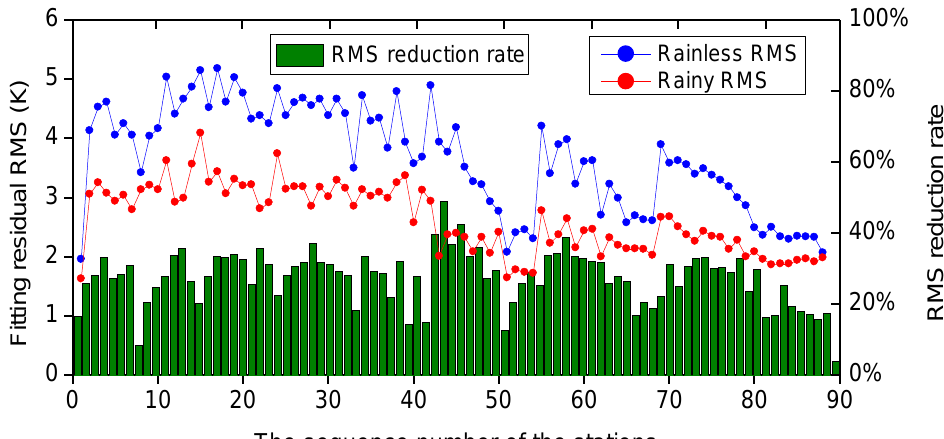
Figure 11. Regression precision of the rainy-day model and the rainless-day model for each station. The correspondence between the sequence numbers (horizontal axis) and station names is shown in Table A1 of Appendix A (columns 1 and 2). The red dot (blue dot) represents the RMS about the regression of rainy-day model (rainless-day model). The green bar denotes the reduction rate of rainy-day model RMS relative to the rainless-day model